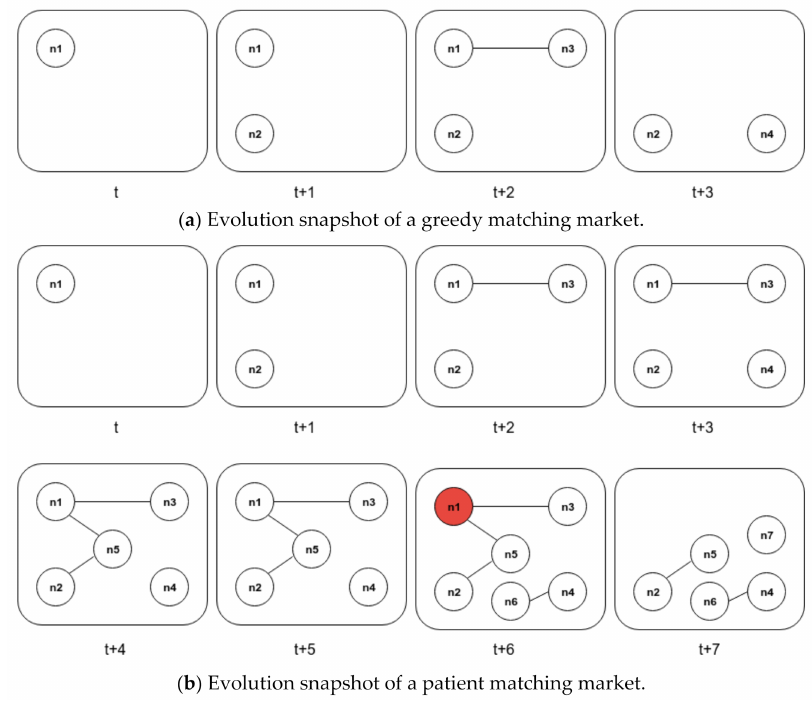
Figure 9. Dynamic matching market under ( a ) the greedy algorithm and ( b ) the patient